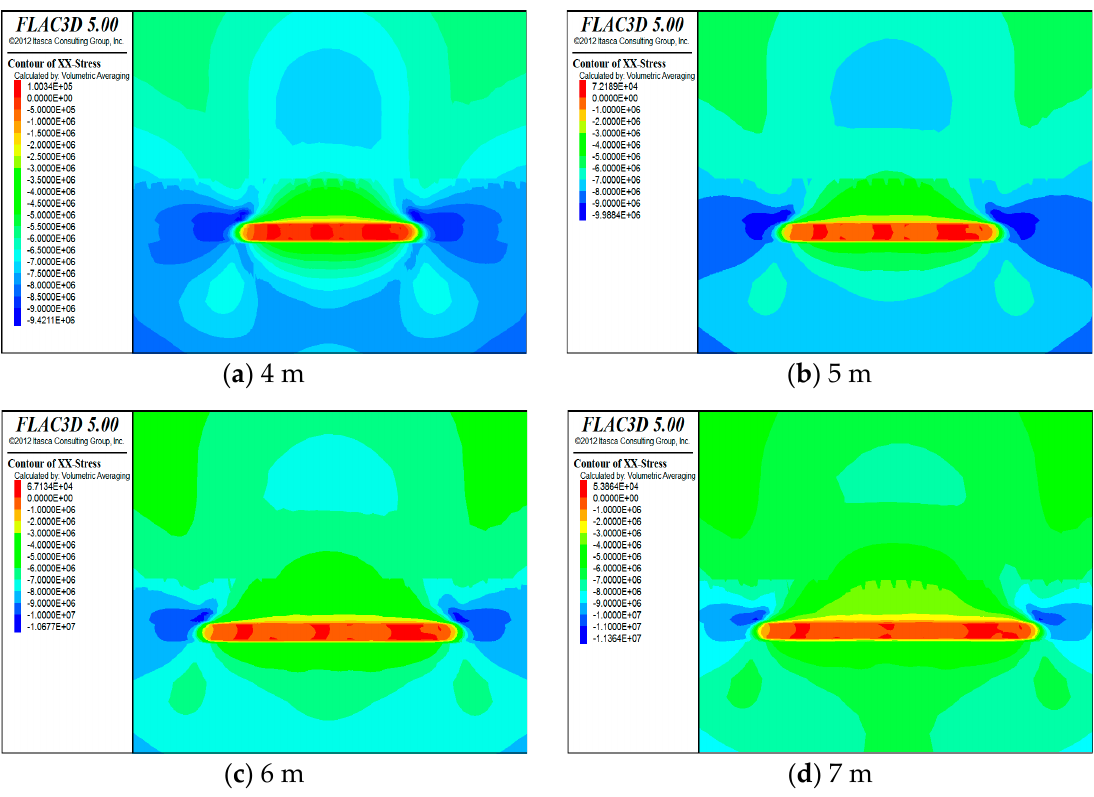
Figure 15. Cloud of vertical stress distribution for ( a ) 4 m, ( b ) 5 m, ( c ) 6 m, and ( d ) 7 m.